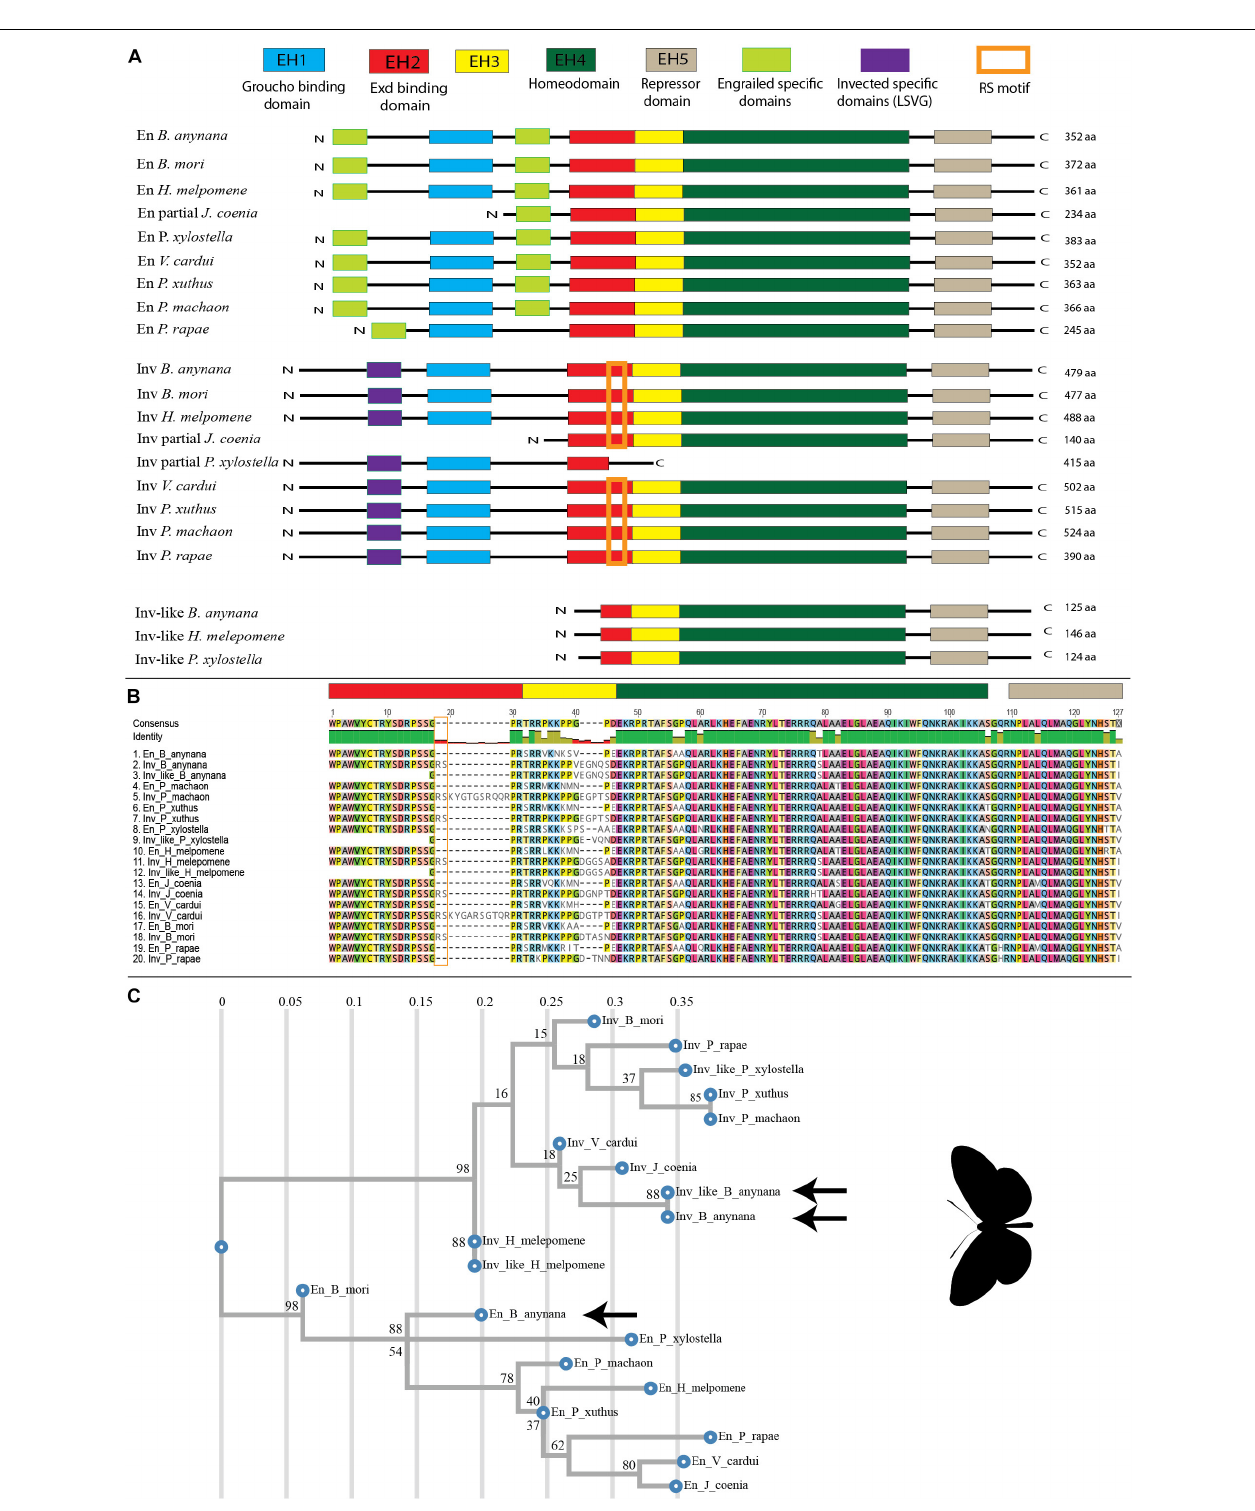
FIGURE 2 | Alignment and Phylogenetic tree of En-family proteins in Lepidoptera. (A) En-family proteins have five conserved domains named EH1 to EH5. En and Inv contain all the five En-family domains along with gene-specific domains, while Inv-like only contains three complete domains (EH3 to EH5) and one partial domain (EH2). (B) Alignment of En-family proteins around the conserved EH2-EH5. (C) Phylogenetic tree of En-family protein created using RAxML (Stamatakis, 2014). En proteins cluster together; and Inv, and Inv-like cluster together. Arrows point to the B. anynana paralogs. The values on the top axis represent mean number of amino acid substitutions per site and the node values represent branch support calculated based on 100 bootstraps.